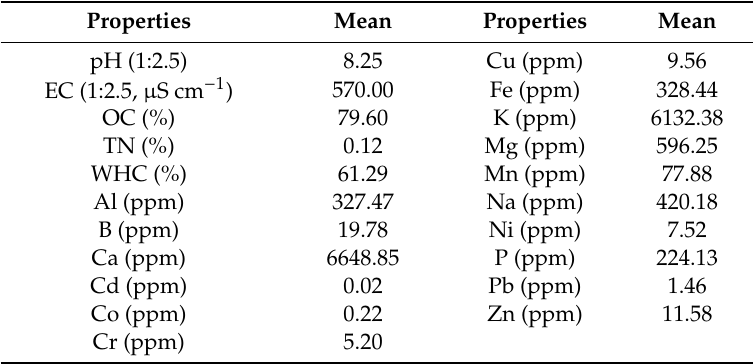
Table 1. Basic properties of biochar derived from a walnut shell.